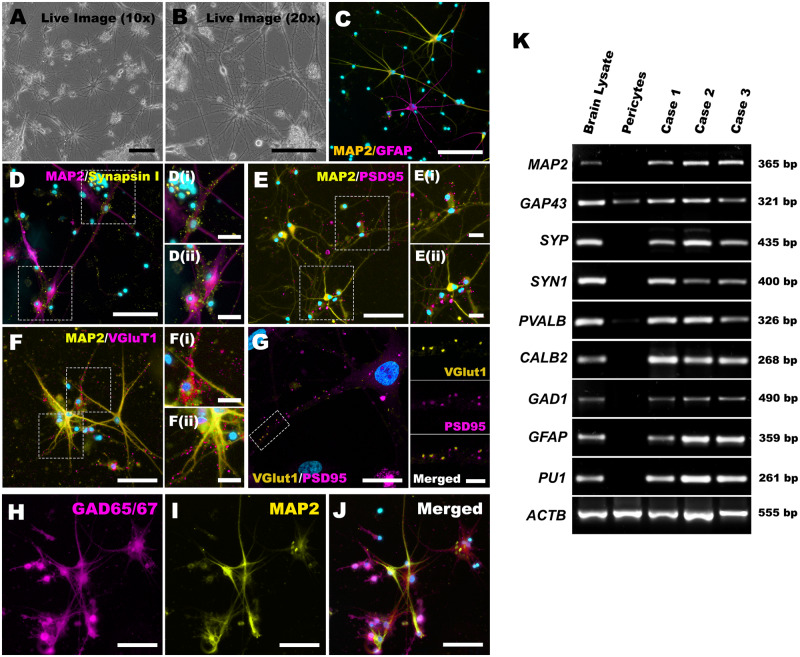

The primary adult human neuronal cultures express mature neuronal and synaptic markers. (A, B) Phase-contrast images from a live neuronal culture at 21 DIV. (C) Co-existence of neurons (MAP2+) and astrocytes (GFAP+) in the cultures. The MAP2+ neurons also expressed synaptic markers, synapsin I (D), PSD95 (E, G) and VGluT1 (F, G). They also labelled for the inhibitory neuronal marker, GAD65/67 (H–J). ICC studies were conducted on 19/46 cases and the representative cases are shown above. Three representative neuronal cultures from three different cases were processed for RT-PCR to probe for the presence of specific genes. The blots showed the amplification of most of the neuronal marker genes and some glial marker genes (K). These were also amplified in a representative brain lysate (positive control). The majority of the neuronal genes did not amplify in non-neuronal pericyte cultures (negative control). For the RT-PCR studies, Case 1 was superior frontal gyrus from an intra-ventricular meningioma surgery, Case 2 was a right parietal lobe resection from a GBM surgery and Case 3 was a temporal lobe resection as part of a temporal lobectomy surgery for epilepsy. The positive control was a biopsy temporal pole specimen obtained during a GBM surgery, and the negative control was a passage 7 pericyte culture derived from a temporal lobectomy surgery, similar to that of Case 3. Scale: A–F and H–J = 100 µm (insets = 20 µm); G = 20 µm (insets = 5 µm)